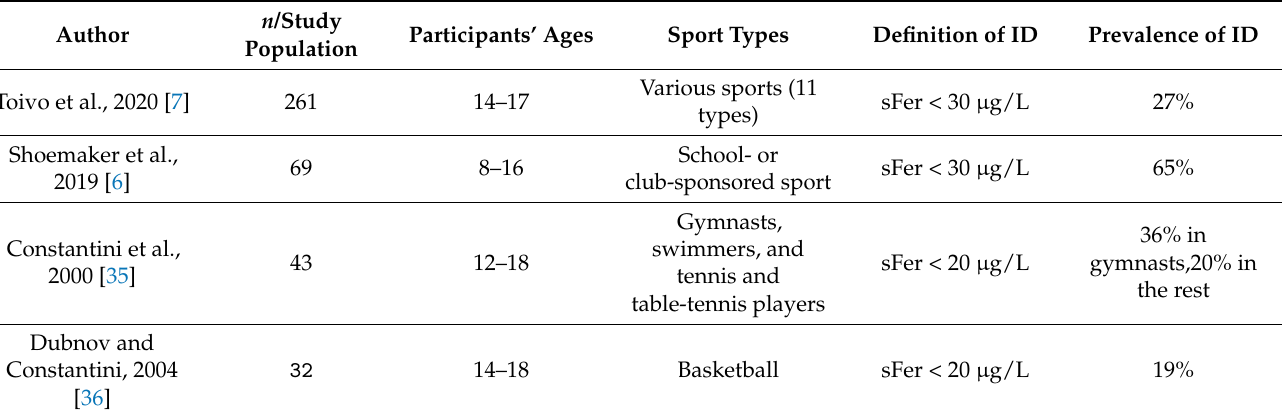
Table 3. Iron deficiency in male adolescent